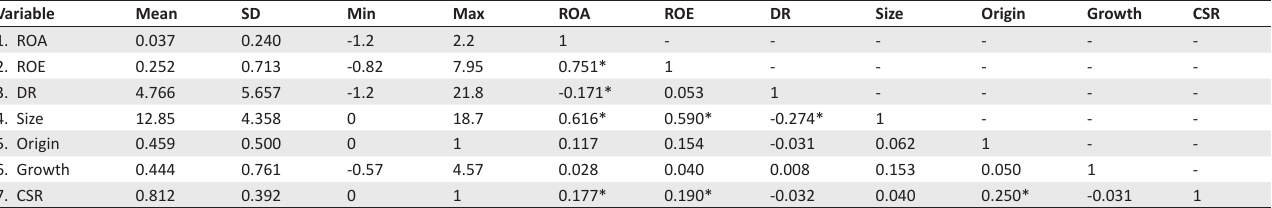
TABLE 3: Summary descriptive and correlation statistics for both dependent and independent variables. Variable